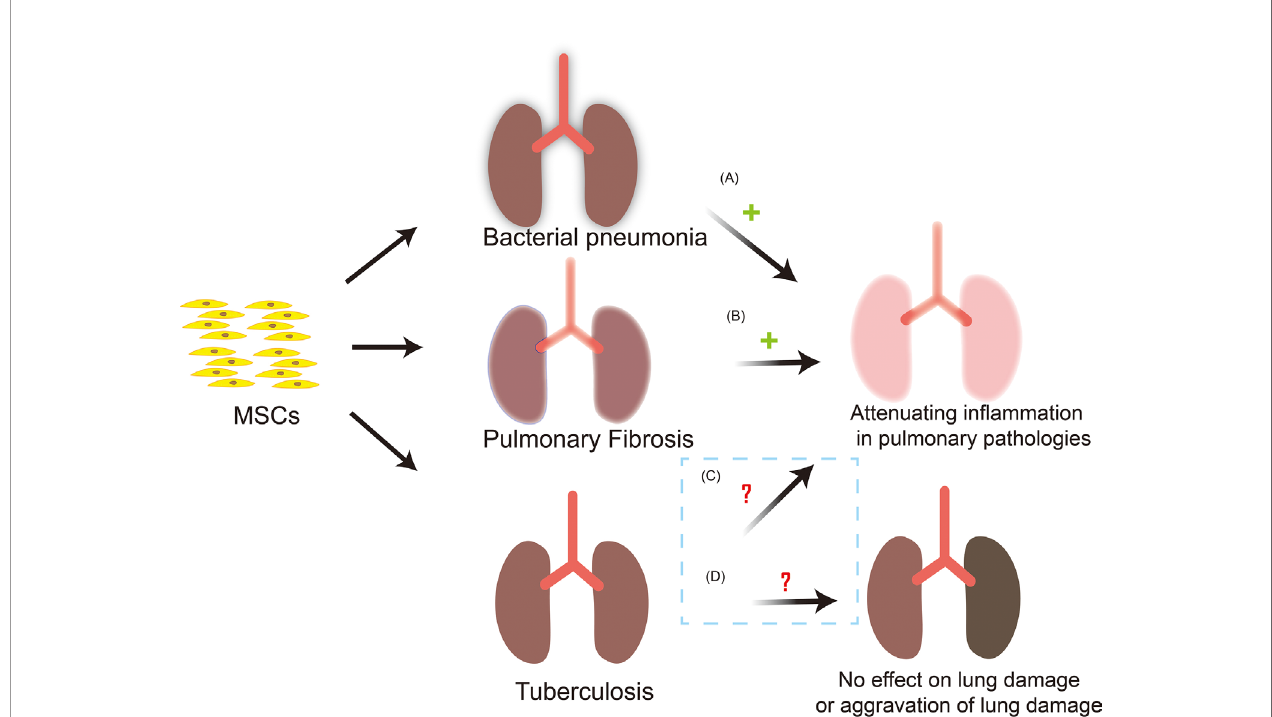
FIGURE 3 | MSCs-based clinical application and possible outcomes for TB. MSCs are used in the treatment of bacterial pneumonia and PF, and have achieved good results. Nevertheless, the safety and effectiveness of MSCs in the treatment of tuberculosis need to be further con fi rmed. (A) MSCs can reduce the severity of bacterial pneumonia, reduce the bacterial load in the lungs and inhibits in fl ammation, and reduce lung injury. (B) After MSCs infusion, there are fewer in fl ammatory cells in the lung interstitium and collagen fi bers. The deposition in lung tissue is reduced and the degree of pulmonary fi brosis is reduced. (C) MSCs infusion can effectively reduce the in fl ammatory response in vivo , hinder the development of fi brosis in the lesion site, and does improve the prognosis of TB patients to a large extent. However, the safety and effectiveness need to be veri fi ed. (D) During Mtb infection, MSCs may not be able to effectively regulate the local immune response and the course of disease. In addition, MSCs have immunosuppressive properties, and its infusion may have the risk of worsening of TB or the reactivation of latent Mtb, so the safety and effectiveness of MSCs in the treatment of TB are issues worthy of in-depth exploration. +: outcomes are effective; ?: outcomes are